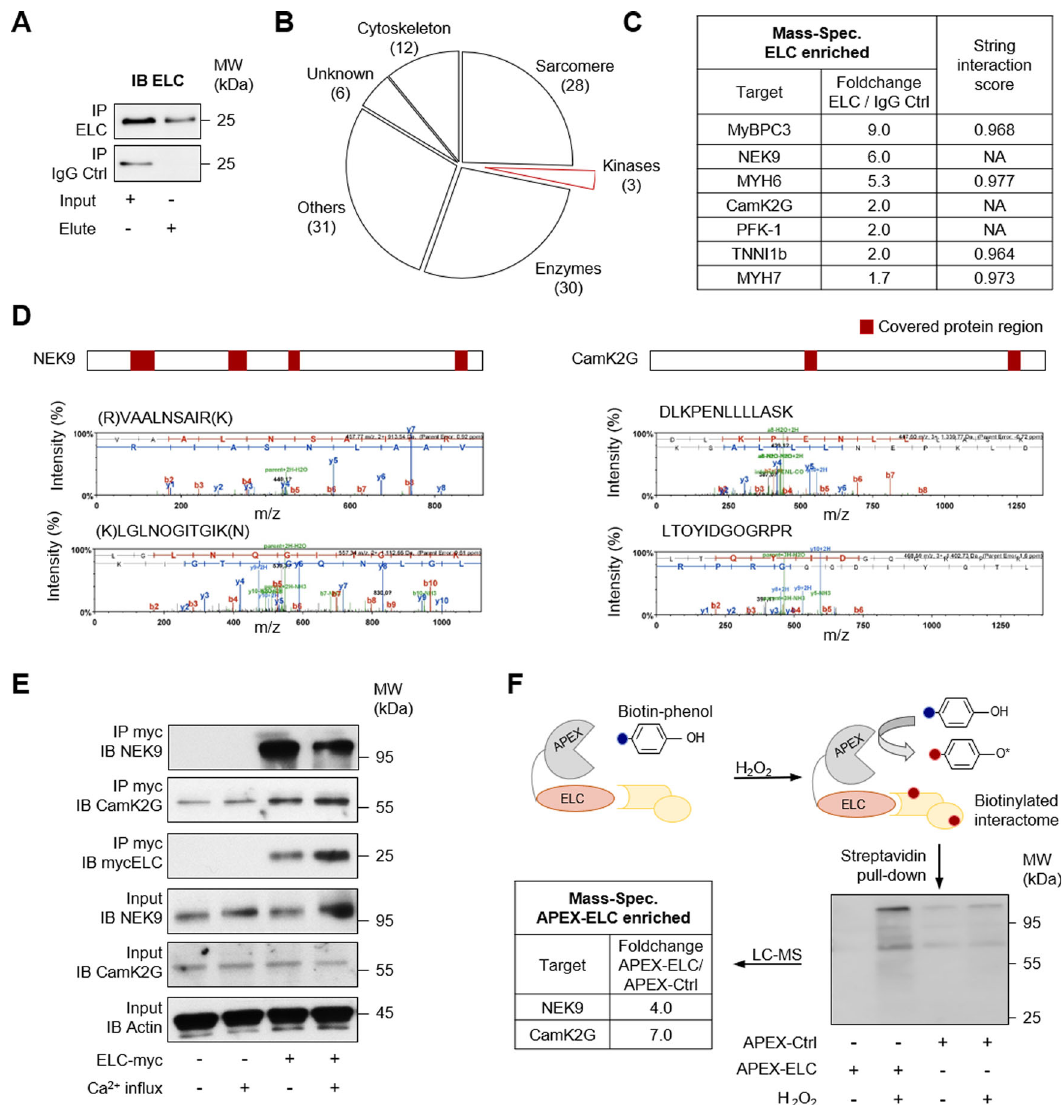
Fig. 1 | Identi fi cation of ELC kinases in adult piscine heart protein. Immuno- precipitation (IP) was performed by using custom ELC antibodies covalently cou- pled to magnetic beads. Liquid chromatography followed by mass spectrometry (LC-MS) was used for identi fi cation. A Validation of ELC precipitation by immu- noblot(IB)beforeperformingLC-MS(see B and C ). B Classi fi cationofELCenriched proteins identi fi ed by LC-MS. From 3452 spectra 110 proteins were identi fi ed in total. 106proteins werefoundto interactwith ELC.3 different kinases werefound. (Peptide FDR: 5%, minimum of two identi fi ed peptides per protein) C Ranking of